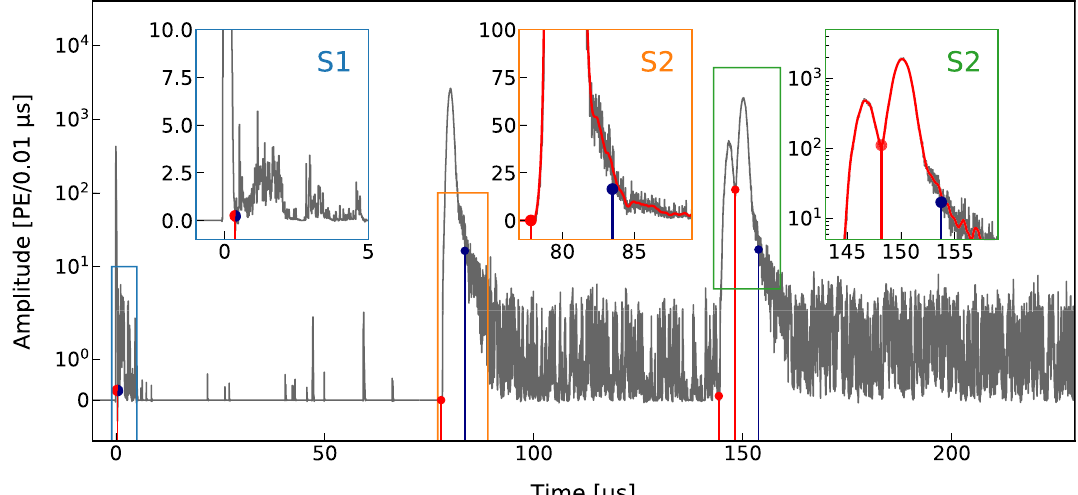
Fig. 2 A sample WF (after correction) of a high-energy event induced byaseriesofComptonscattersintheLXe.ThesummedWFsareshown asgreylineswhilethesmoothedsummedWFsareshownastheoverlaid red lines in the insets. The WF of such an event typically has a narrow S1 peak and a few S2 peaks, each of which is followed by secondary signals from AP and PI processes. The effect of the algorithms on each